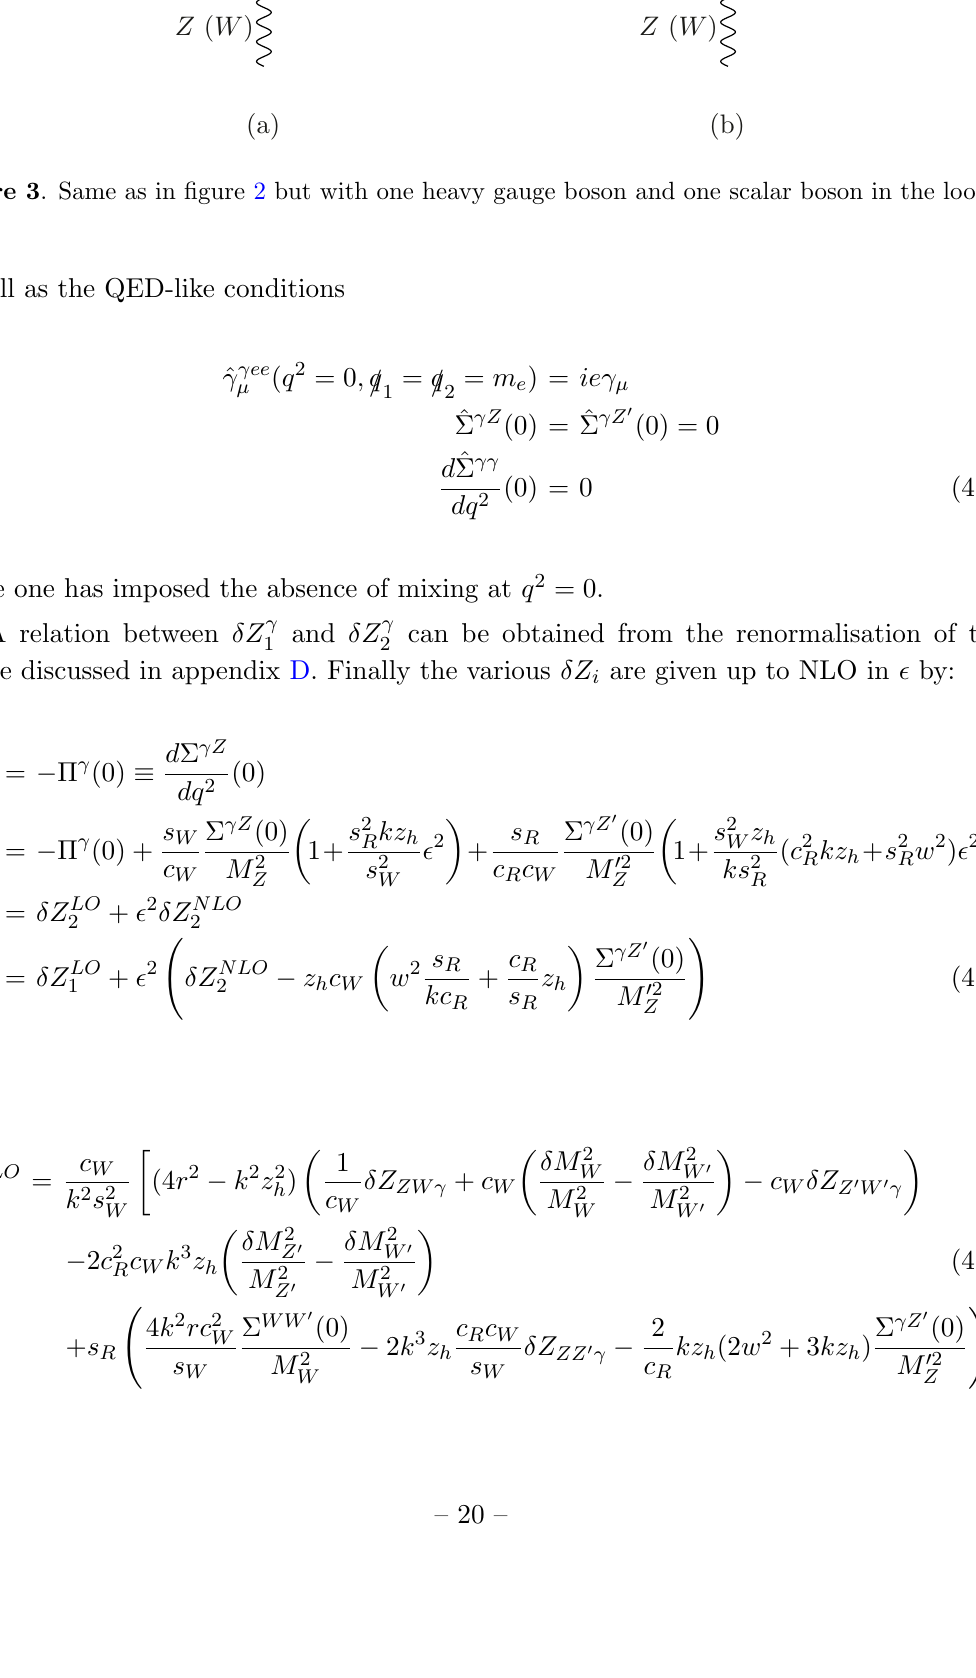
Figure 3 . Same as in (cid:12)gure 2 but with one heavy gauge boson and one scalar boson in the loops.